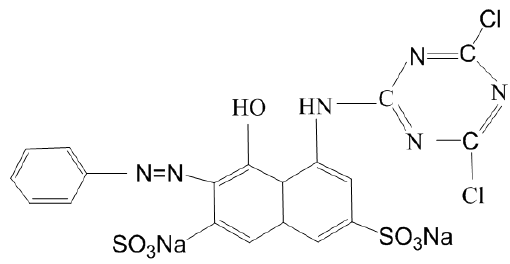
Figure 1. Chemical structure of reactive brilliant red X ‐ 3B.